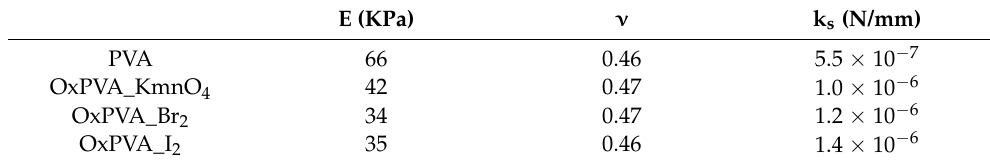
Table 2. Optimal parameters: Young’s modulus, Poisson’s ratio, and specific permeability.